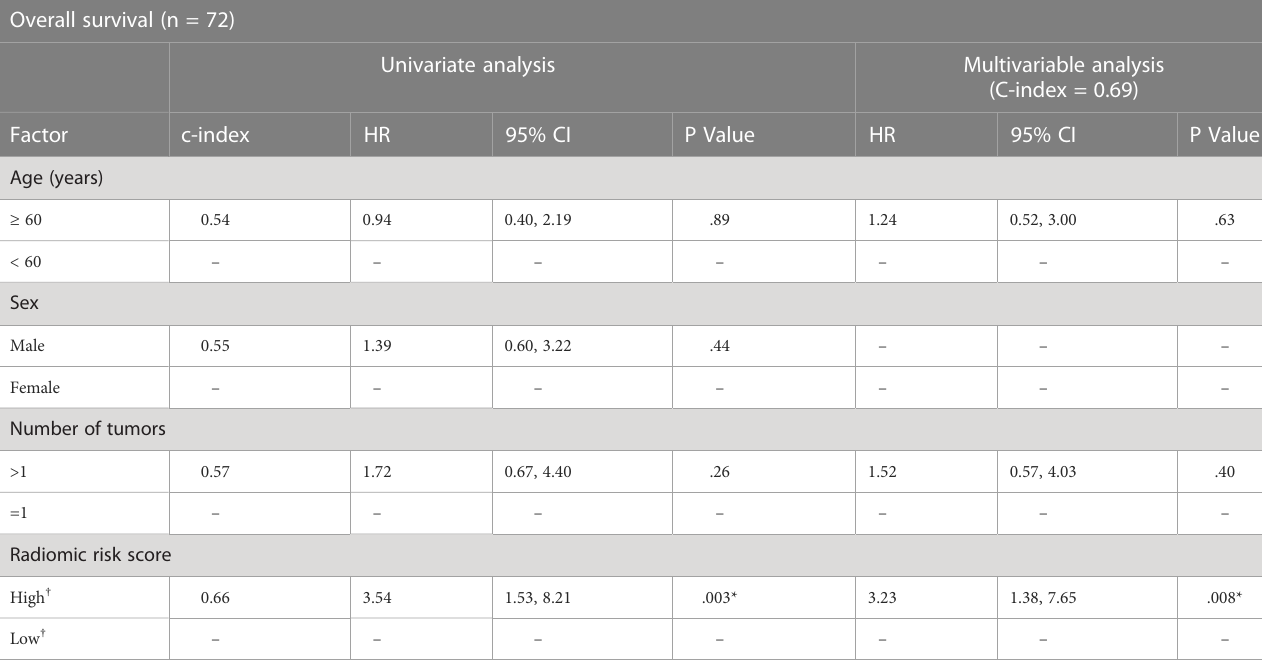
TABLE 3 Cox regression model results for the association of radiomics biomarker with overall survival in the Gd-EOB-DTPA cohort. Overall survival (n =